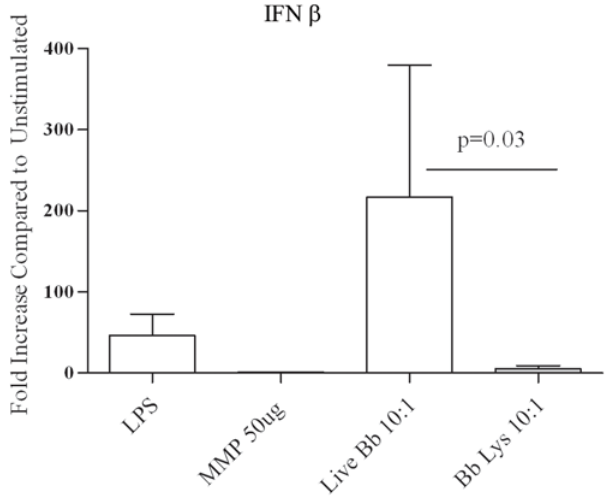
Figure 4. Live Bb, but not borrelial lysates or synthetic TLR2 ligands, induce IFN- b transcription in isolated human mono- cytes. Monocytes were incubated with live or lysed Bb MOI (10), 100 ng/ml of lipopolysacharide (LPS) and the 10 m g/ml of the TLR2 ligand MMP (Mitogenic pentapeptide). Transcription of IFN- b was determined by qRT-PCR. Bars depict the means + / 2 standard error of the mean from a minimum of four independent experiments. P value shown corresponds to the statistical comparison between live and lysed Bb (MOI 10:1) induced IFN- b transcripts.